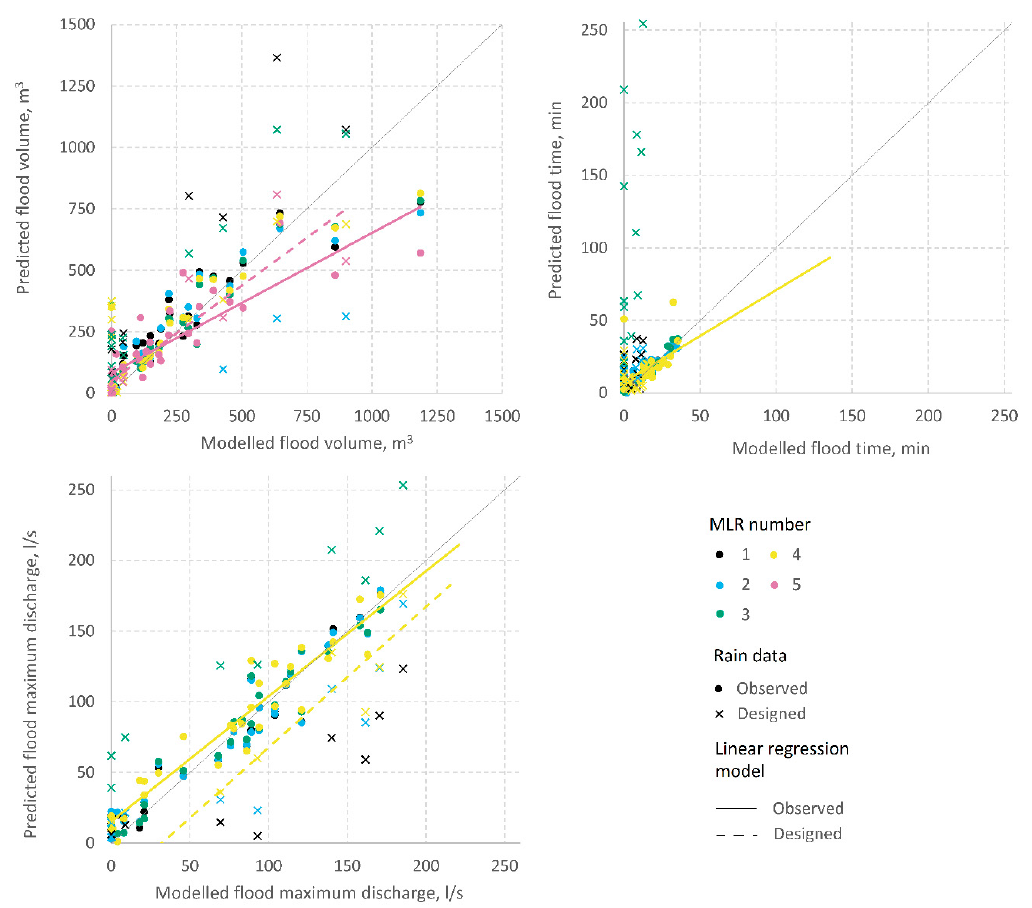
Figure 8. MLR performance.